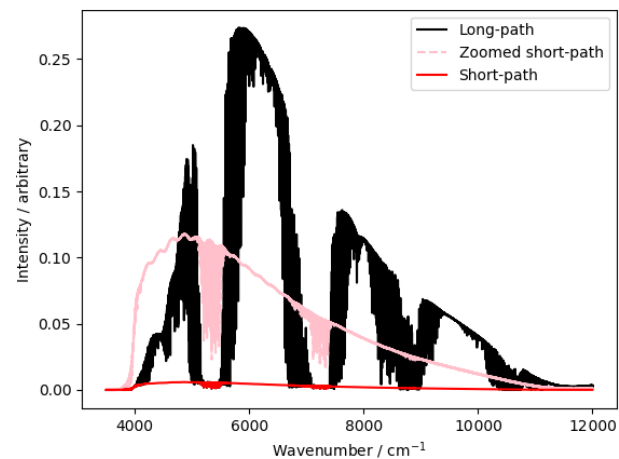
Figure 2. Example long-path spectrum (23:48AEST (Australian eastern standard time) 5 December 2018, black) and original (red) and 20 × zoom (pink) short-path spectrum (21:48AEST 2 Decem- ber